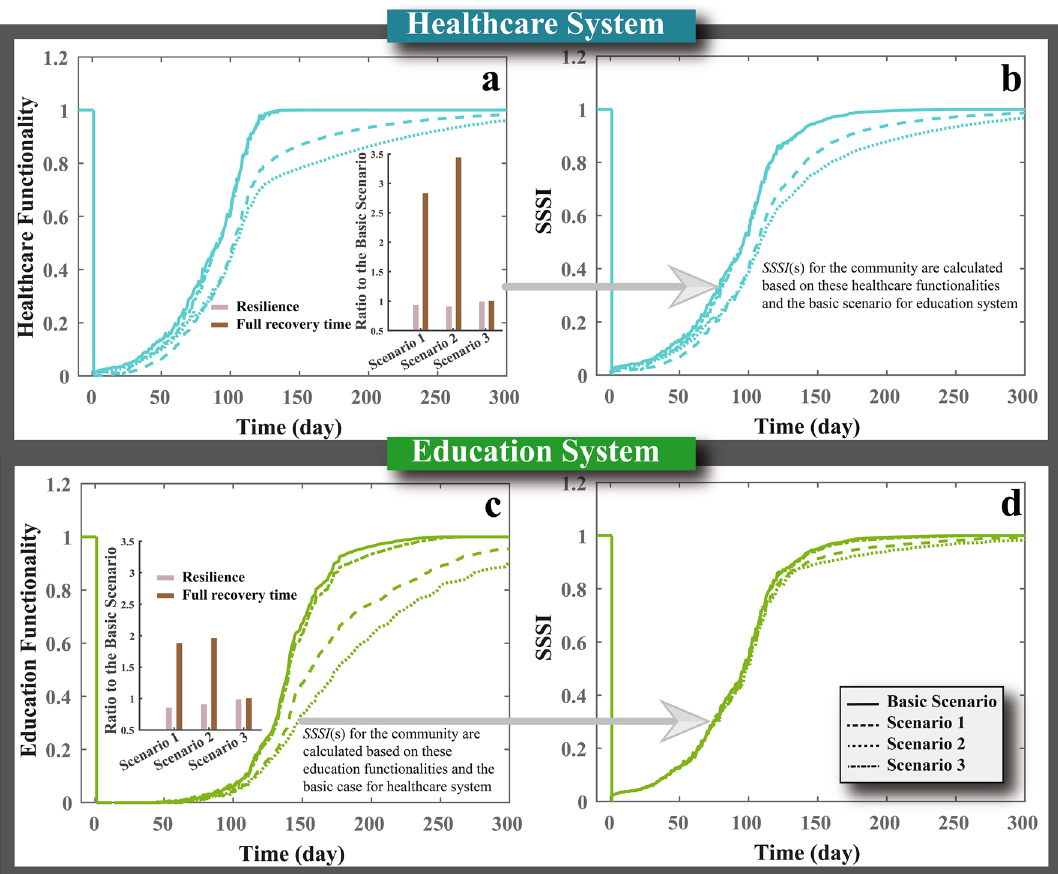
Figure 5. Impact of failing to apply different mitigation strategies on ( a ) the total functionality of healthcare system, ( b ) community’s SSSI , ( c ) the total functionality of education system, and ( d ) community’s SSSI . The Basic Scenario case refers to the case when all the mitigation strategies applied, Scenario 1, represents the case when the no mitigation for staff, Scenario 2, denotes the case when no mitigation strategies for utilities and space are applied, and Scenario 3, indicate the case when no mitigation strategies are